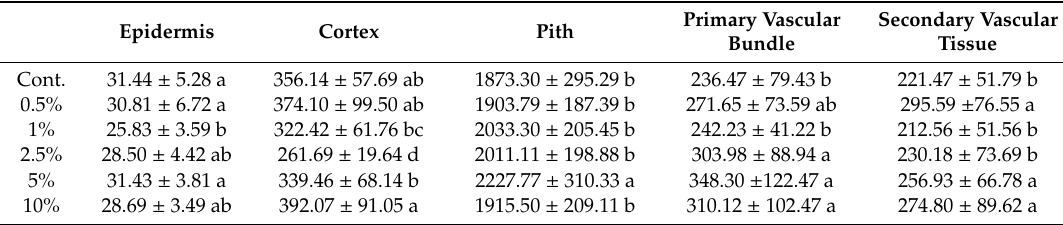
Table 3. Impact of di ff erent concentrations of fermented brown juice on stem tissue of Celosia argentea var. plumosa ( µ m ) (mean ± SD, n =